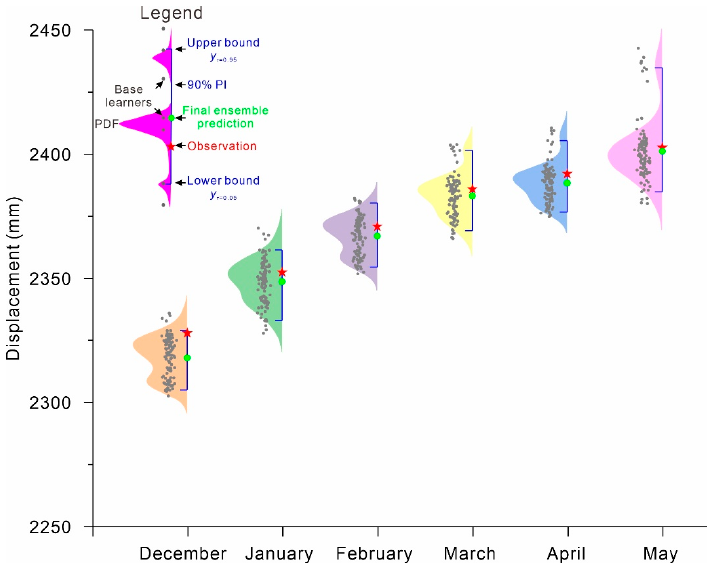
Figure 8. PDFs for the Fanjiaping landslide at ZG291 from December 2017 to May 2018.